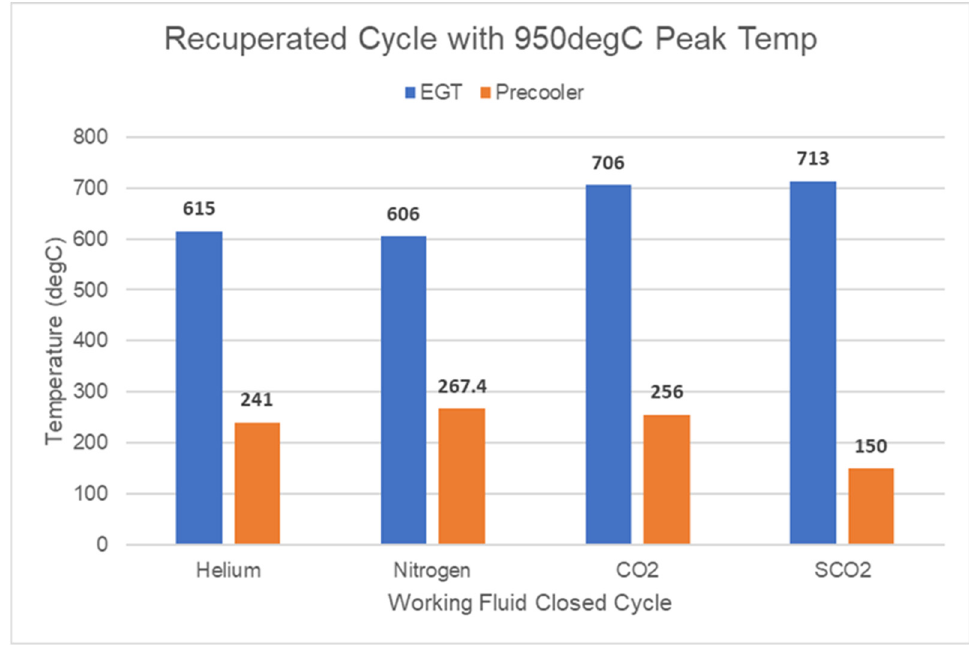
Figure 8. Cycle efficiencies at optimal compressor-pressure ratios (PR). The core-outlet temperature (COT) of 950 °C is equivalent to the temperature at the hydrogen offtake and turbine-entry temper- ature (TET).